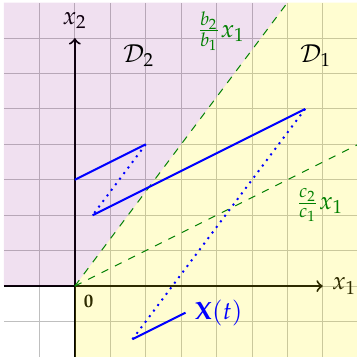
Figure 1. Visualization of the sets